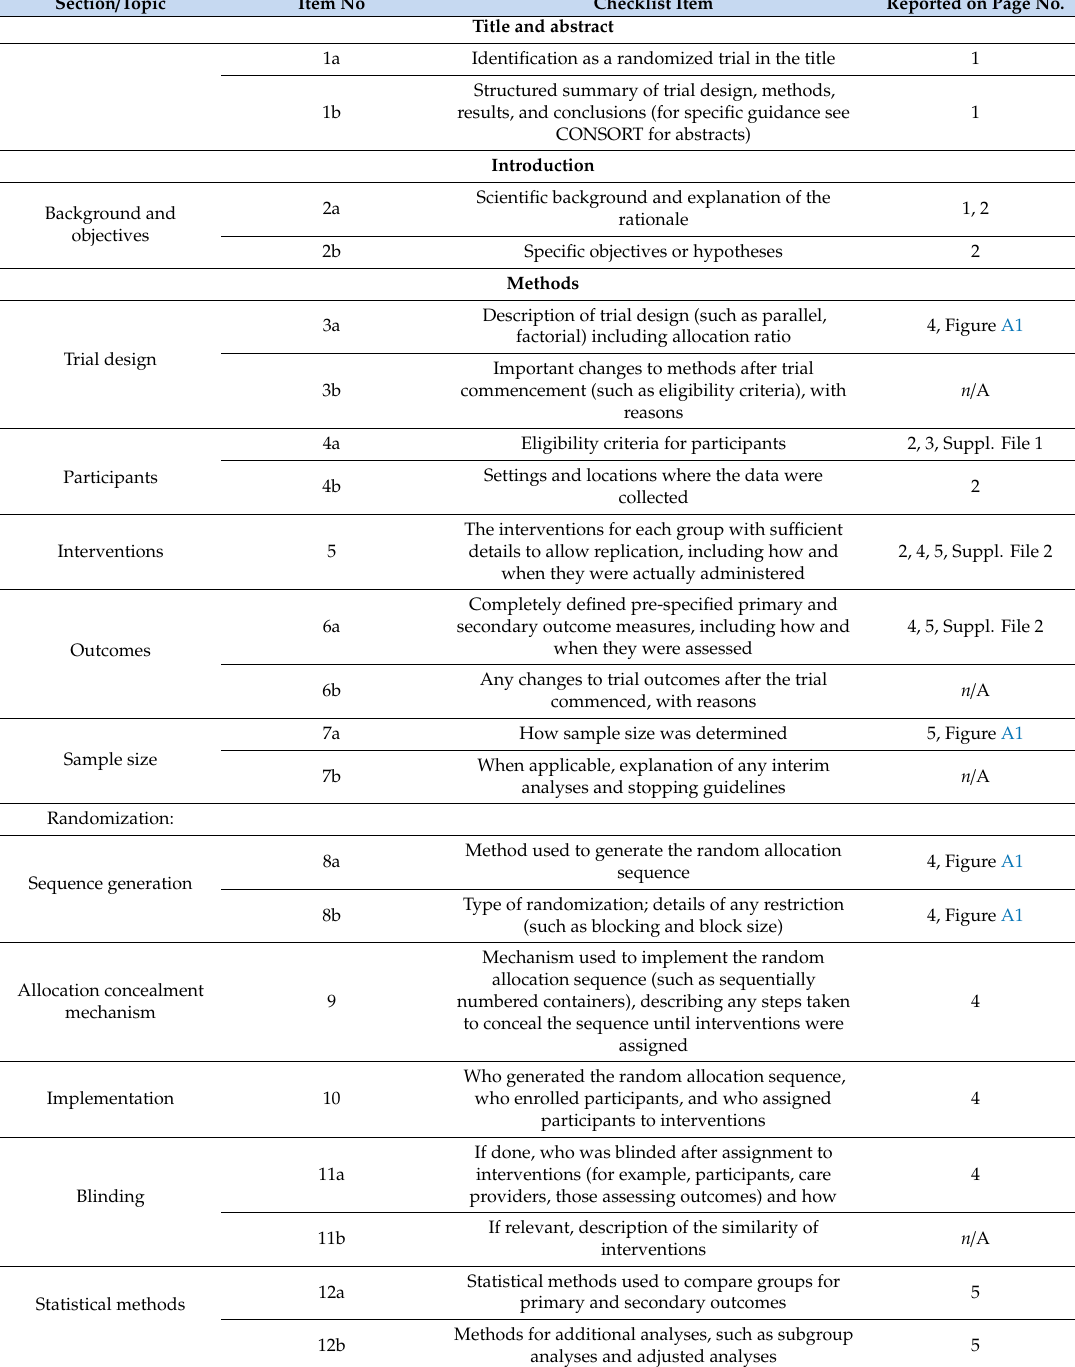
Table A1. CONSORT 2010 checklist of information to include when reporting a randomized